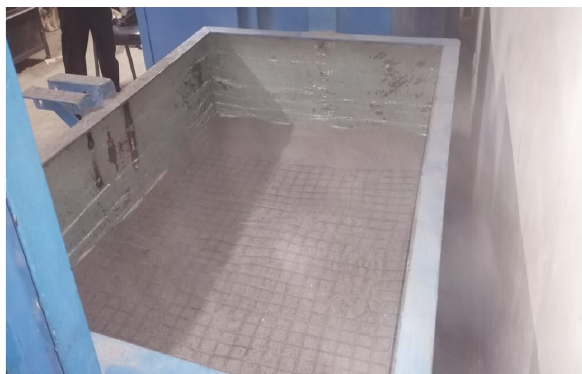
Fig. 4 (a) Cross-section of adopted Figure 4(b): Photographic image of placed Fig. 4 (b) Photographic image of criteria for placement of geogrid placed geogrid